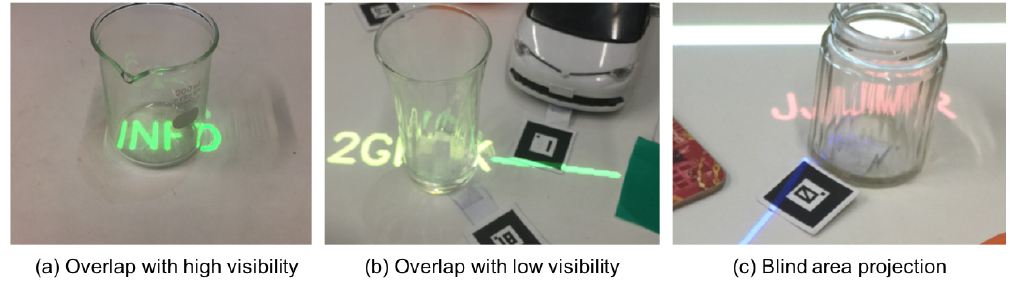
Figure 15. Examples of projection on and behind glass